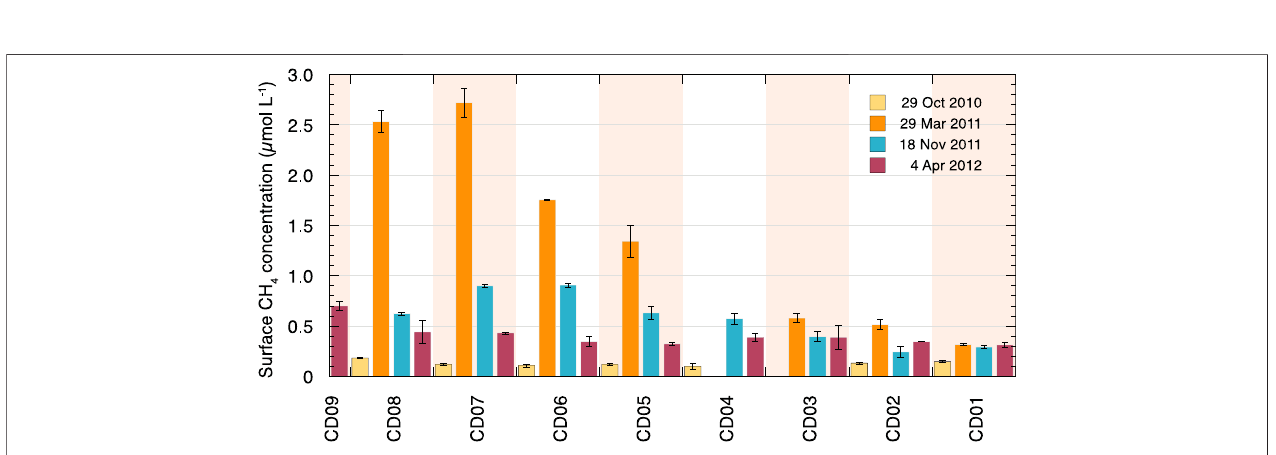
FIGURE 5 | Dissolved methane concentration just below the water surface during the fl ux chamber measurements on 29 October 2010 (beige), 29 March 2011 (orange), 18 November 2011 (blue) and 4 April 2012 (violet). Note that site CD04 was not measured in March 2011 and CD03 was not measured in October 2010. Site CD09 is upstream, site CD01 is